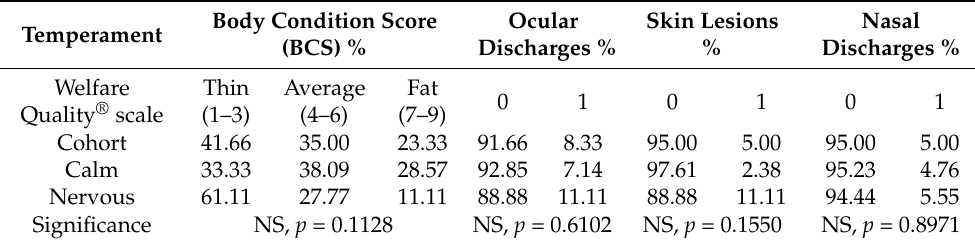
Table 2. Contingency tables for body condition score, ocular discharges, skin lesions, and nasal discharges in calm and nervous buffalo